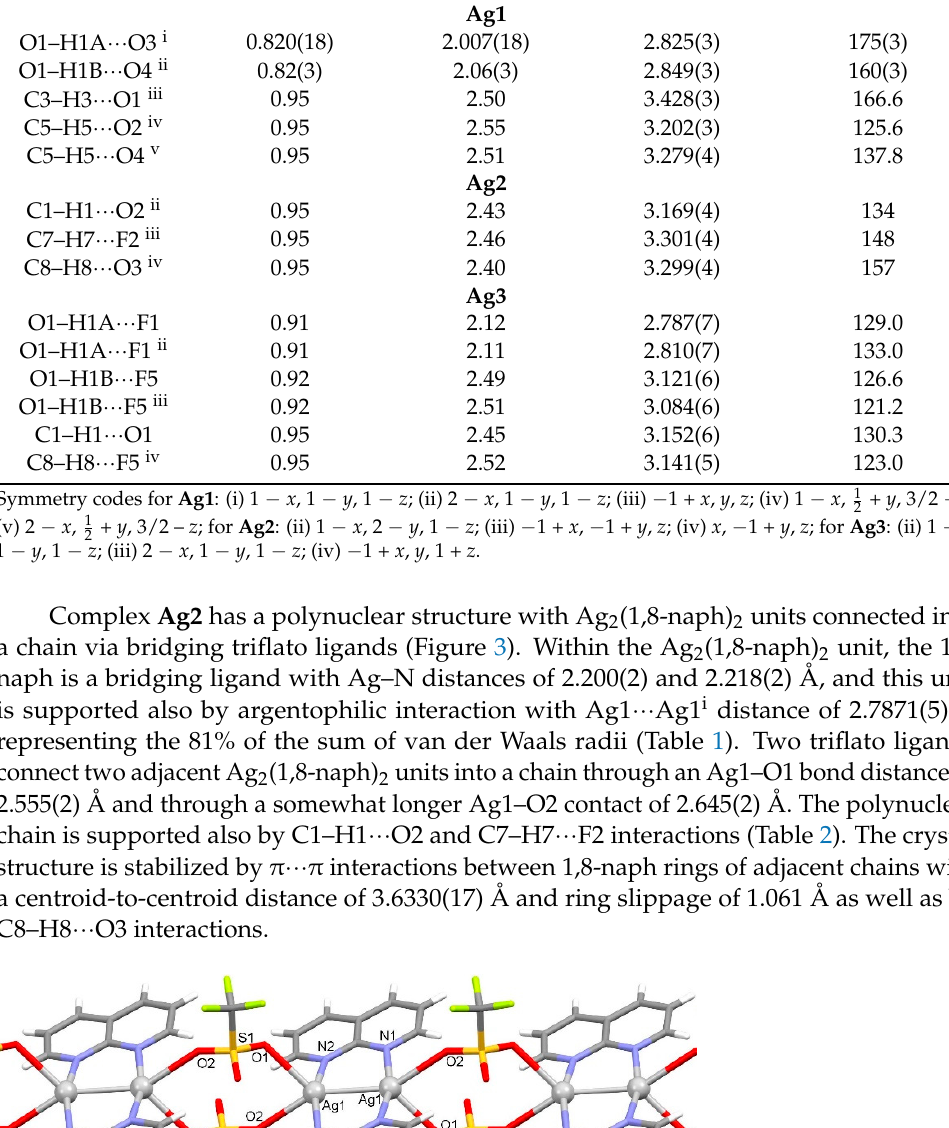
Table 2. Hydrogen-bonding interactions in complexes Ag1 – 3 .